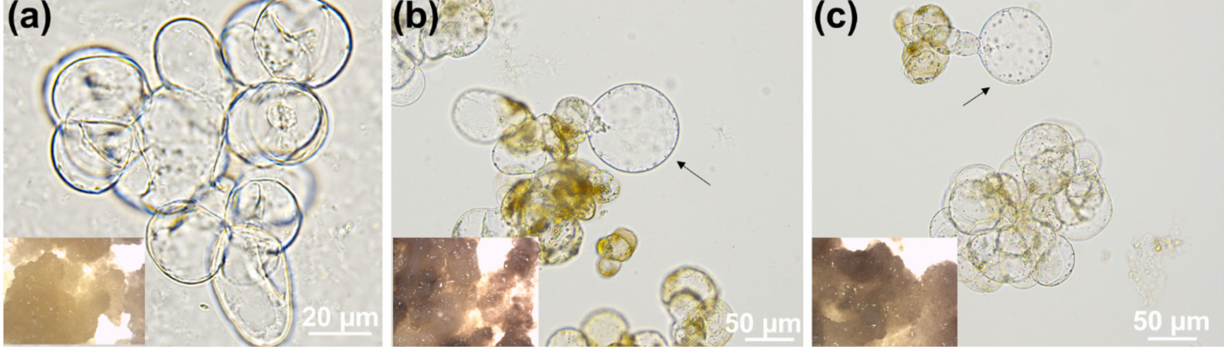
Figure 2. Images of cells and calli (view at the tereomicroscope in the insets) grown under control ( a ), DCB 1 µ M ( b ) and IXB 0.2 µ M ( c ). The arrows point to abnormally swollen